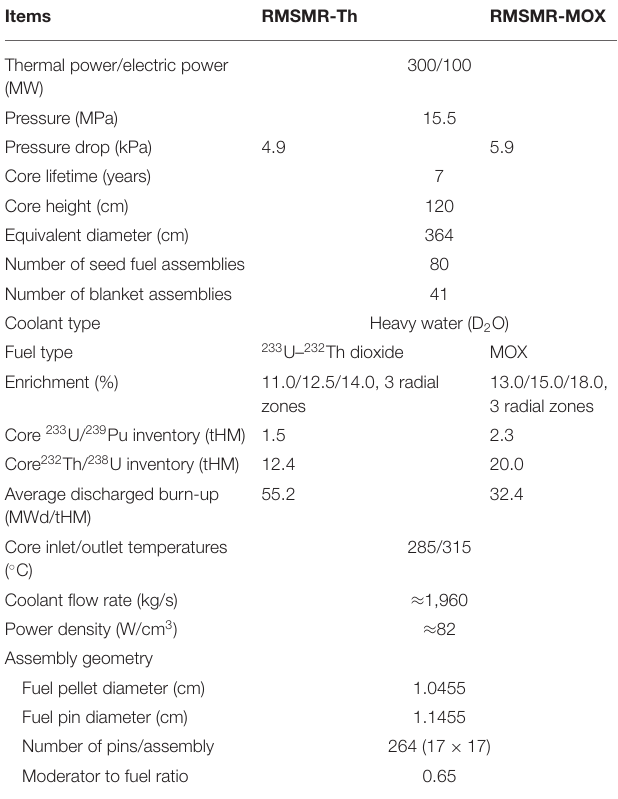
TABLE 2 | Basic reactor design parameters of RMSMR.